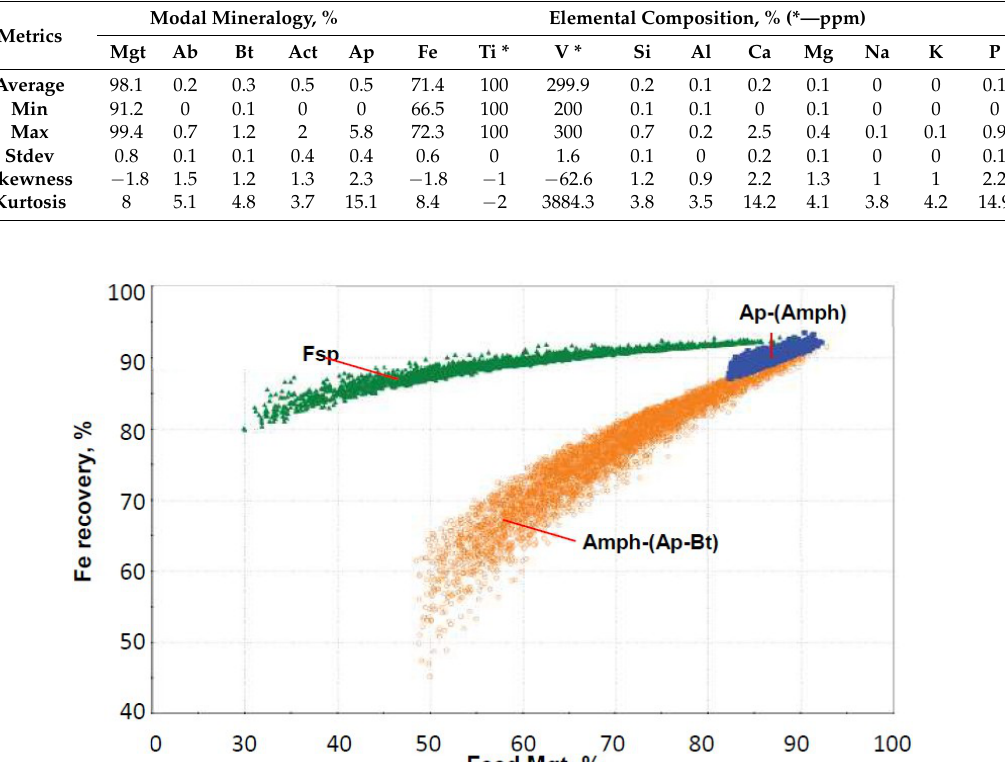
Table 5. Basic statistics of the modal mineralogy and elemental composition of the produced concentrate. Modal Mineralogy, % Elemental Composition, % (*—ppm) Metrics Mgt Average